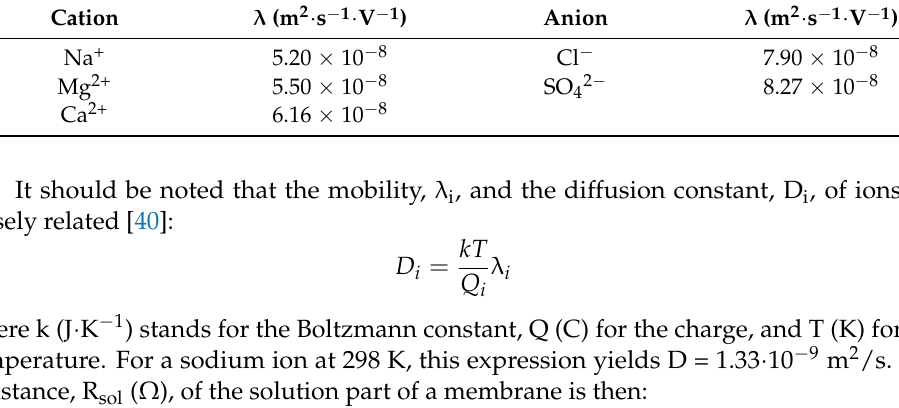
Table 1. Equivalent mobilities in water at 298.15 K [39].